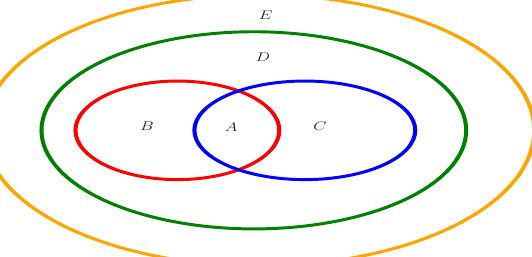
Figure 4. The relationships between the separative T2CA-groupoid and quasi-cancellative T2CA-